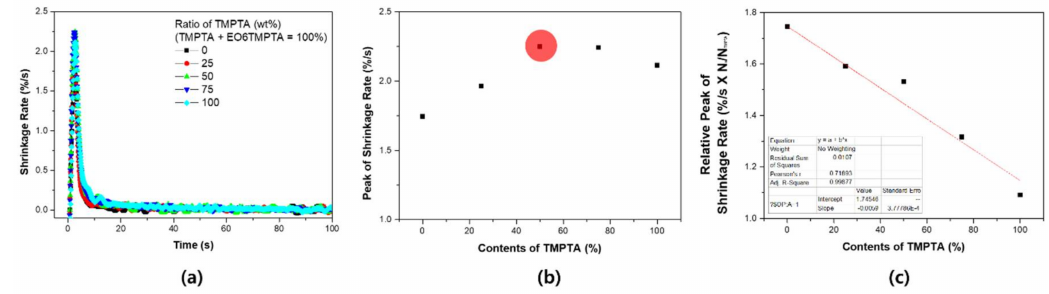
Figure 4. Shrinkage rate of blending system: ( a ) shrinkage rate; ( b ) maximum shrinkage rate of the binary monomer system (red circle: highest heat flow point); and ( c ) relative shrinkage rate with acrylate concentration.